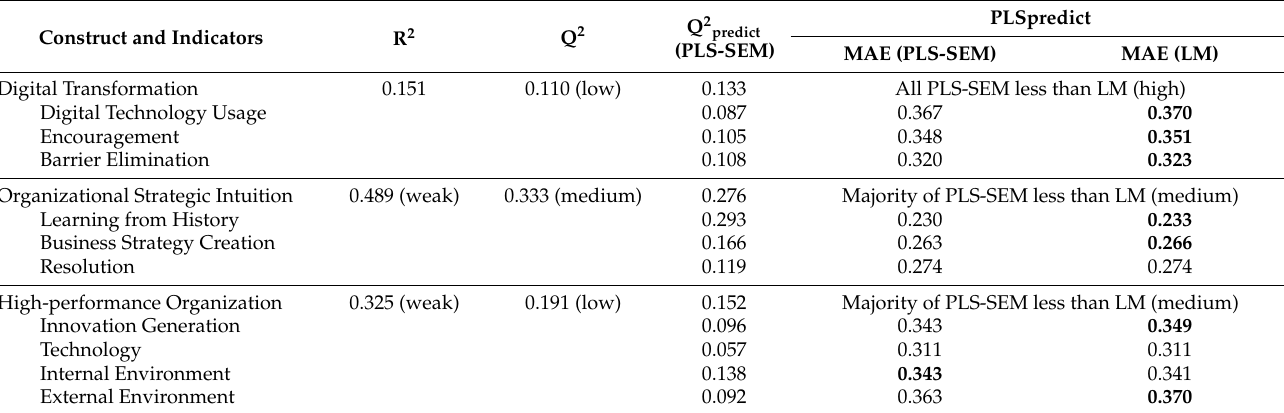
Table 5. Assessing structural